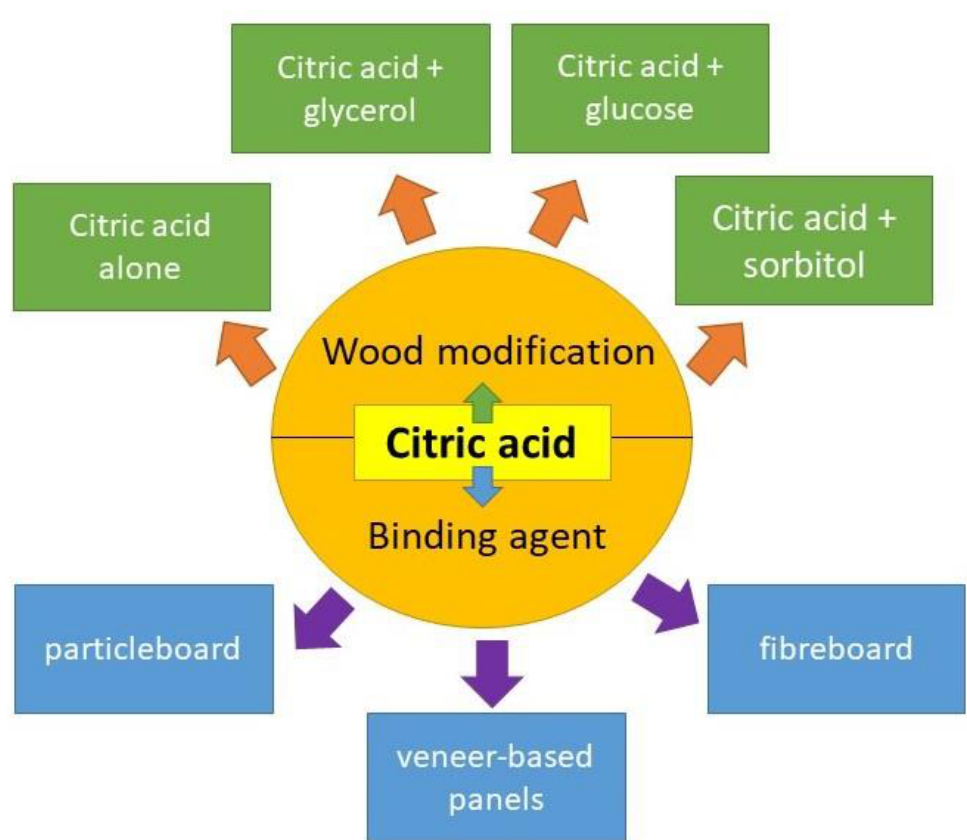
Figure 2. Citric acid as wood modifying agent and binding agent for wood composite.